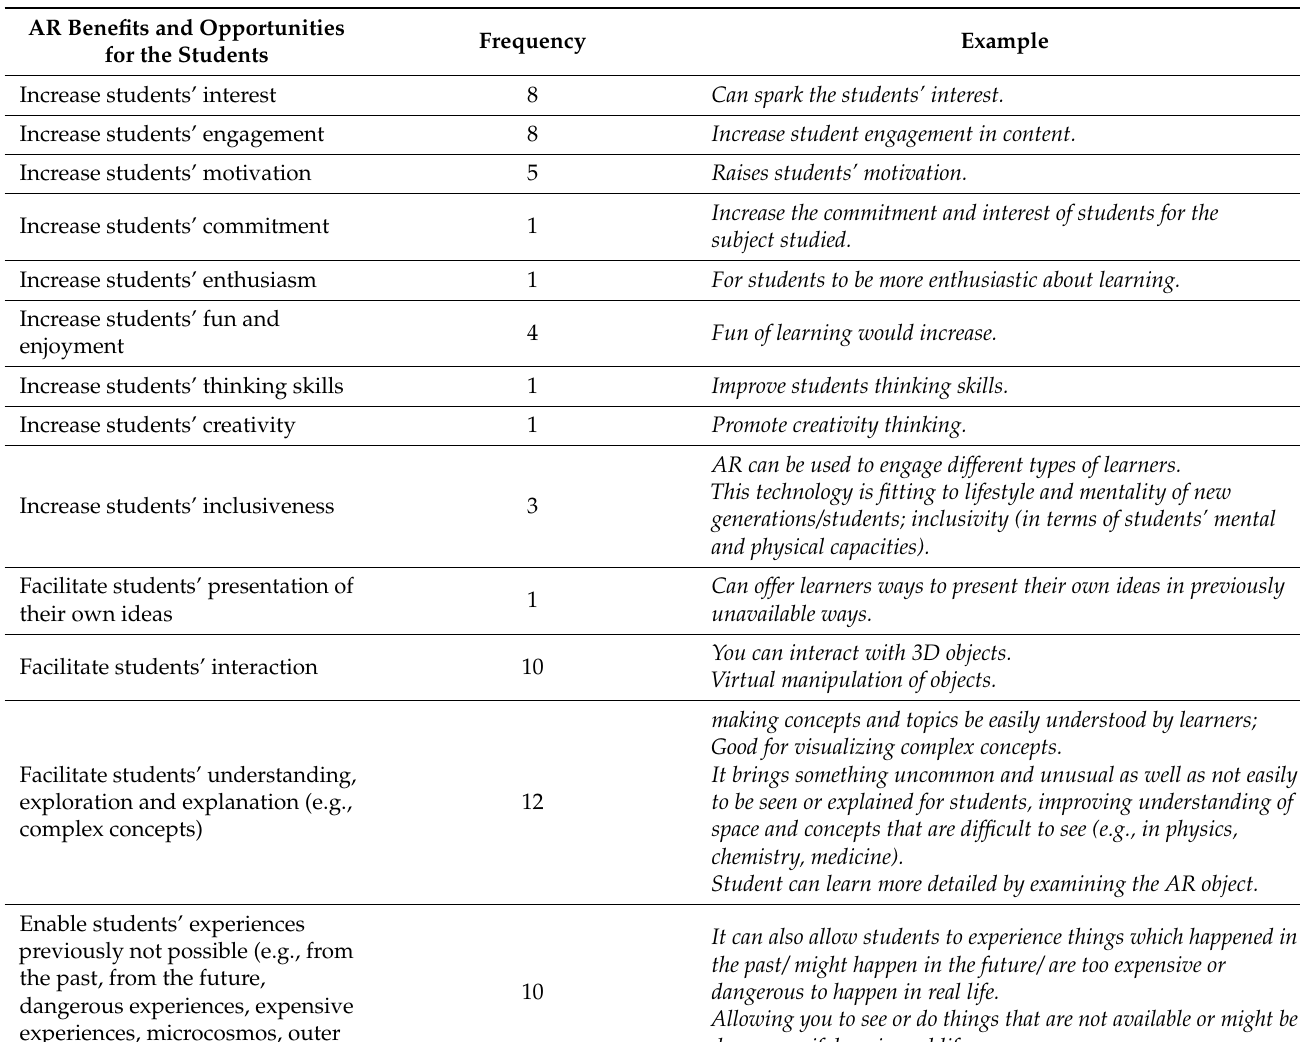
Table 10. Students’ benefits and opportunities of integrating